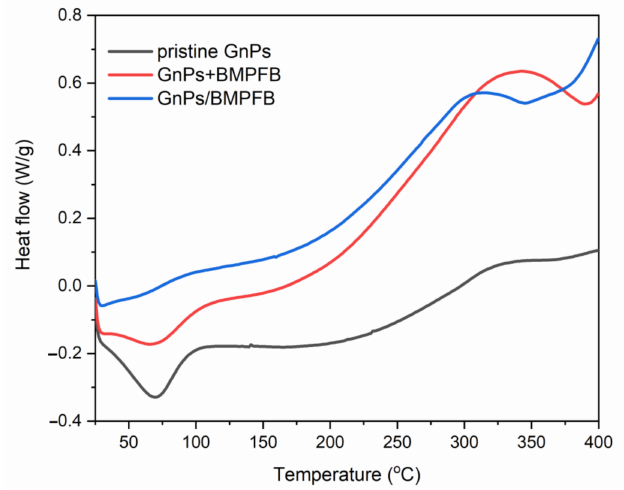
Figure 5. DSC thermograms of pristine GnPs, GnPs treated with BMPFB from solution or GnPs modified in bulk with ionic